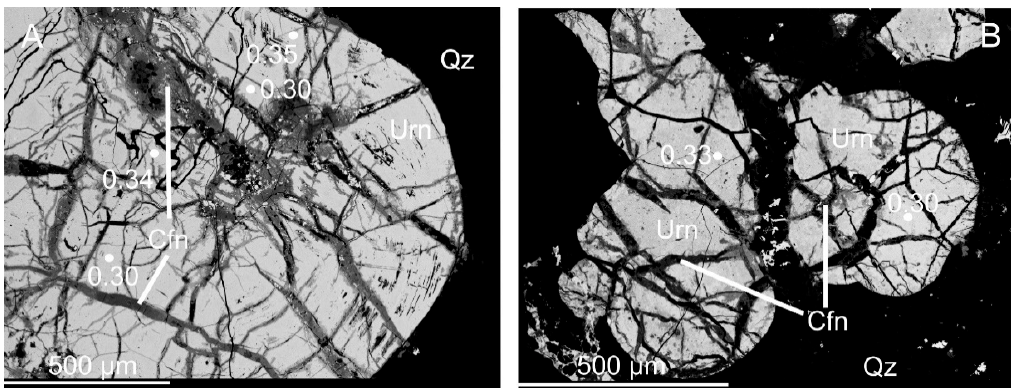
Figure 7. BSE images of uranium mineralization from the Jáchymov uranium district with distribution of Ca ( apfu , O = 4). ( A ) Distribution of Ca in partly zoned uraninite; ( B ) Distribution of Ca in botryoidally evolved uraninite. Urn—uraninite, Cfn—coffinite, Qz—quartz. Minerals 2018 , 8 , x FOR PEER REVIEW